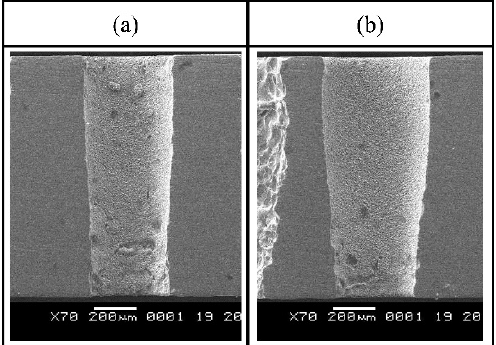
Figure 7. SEM image of micro hole profile under different gap voltage; ( a ) 30 V, ( b ) 50